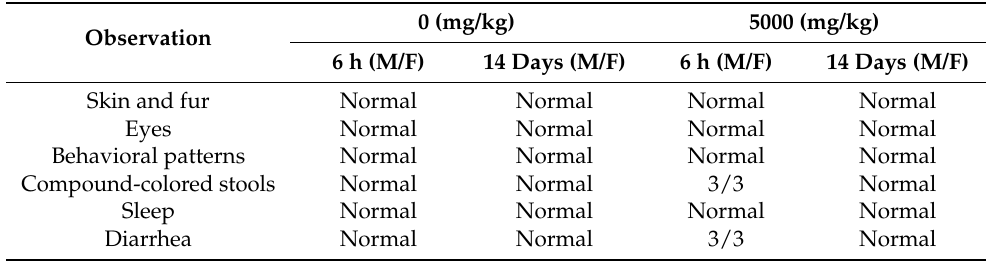
Table 1. General appearance and behavior of the rats during the acute oral